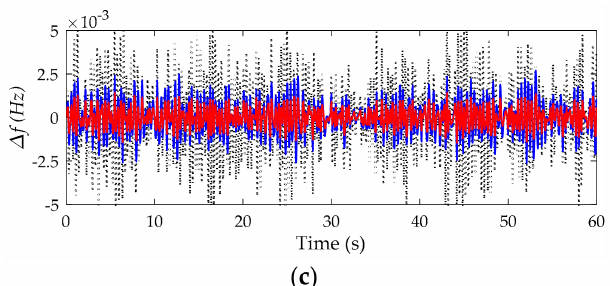
Figure 11. Frequency deviation with parameters perturbation, PID control (black), H ∞ control (blue) and µ -synthesis control (red), ( a ) without parameters perturbation; ( b ) parameters perturbed within 10%; ( c ) parameters perturbed within